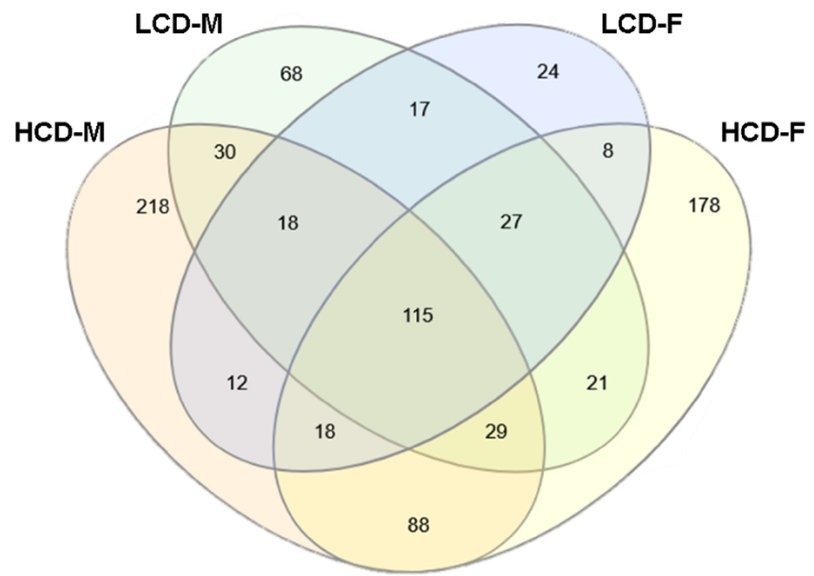
Figure 7. Venn diagram of differential gene expression changes in each group. Similarities and differences in significant ethanol-induced gene expression changes in all four groups. From left to right: high cell death males (HCD-M), low cell death males (LCD-M), low cell death females (LCD-F), and high cell death females (HCD-F).